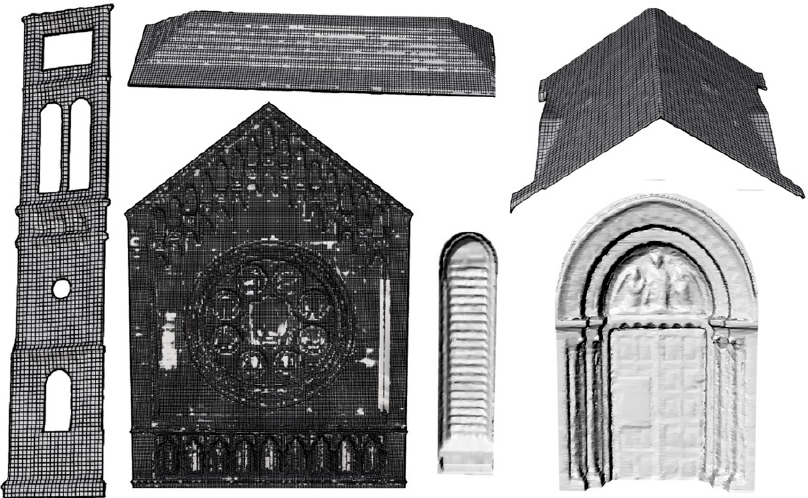
Figure 5 . The segmentation, combination and extrusion process to transfer the holistic surface mesh into individual solid elements